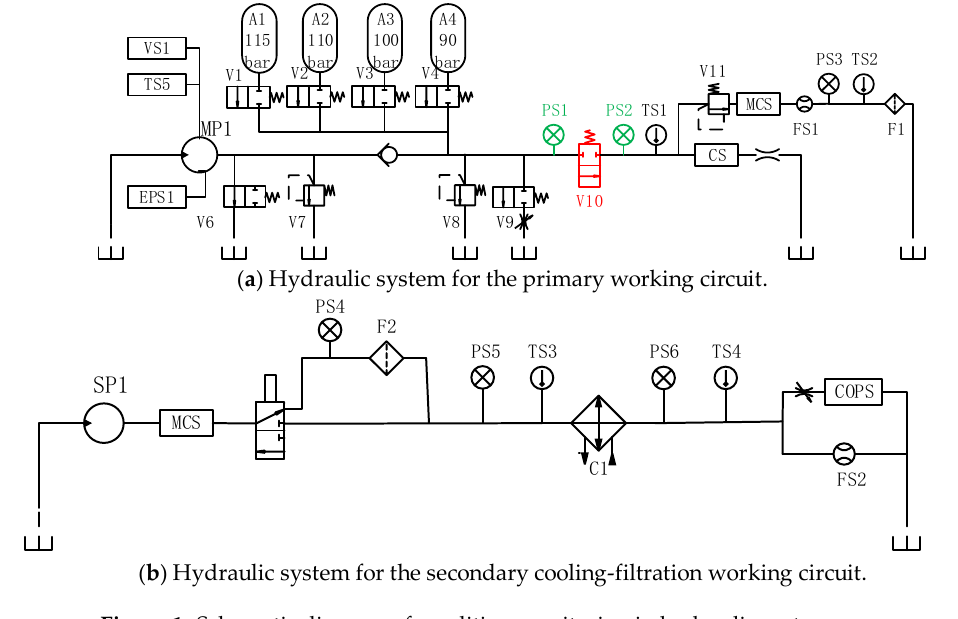
Figure 1. Schematic diagram of condition monitoring in hydraulic systems. Table 1. Sampling rates of